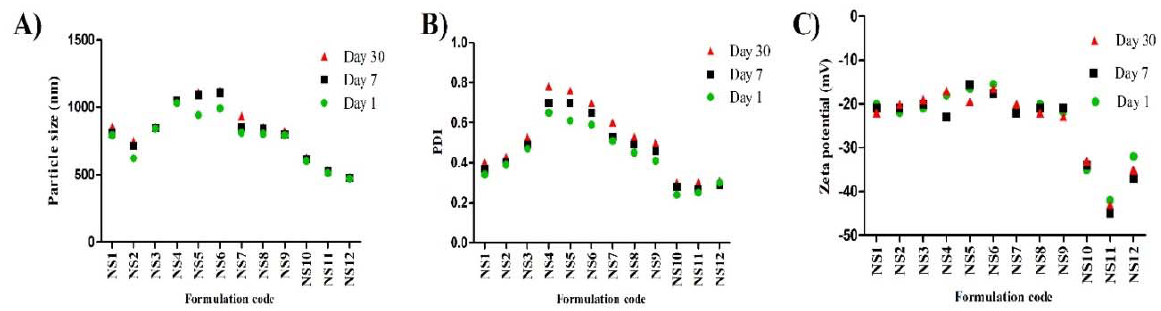
Figure 2. Stability studies of LT-loaded nanosuspensions over the course of 1 month ( n = 3, ± SD): ( A ) particle size, ( B ) PDI, and ( C ) zeta potential.